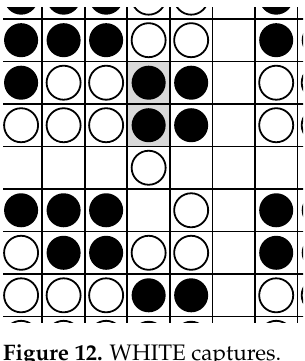
Figure 12. WHITE captures.